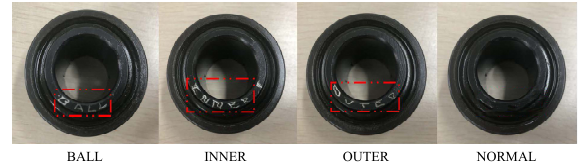
Figure 4. Four bearing health